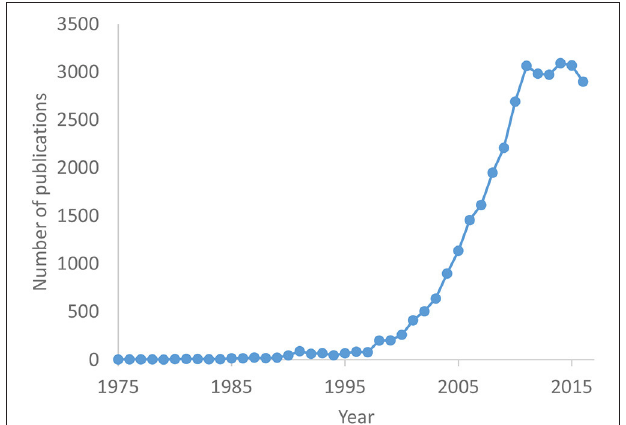
FIGURE 1 | Number of publications registered in Scopus by year, including the words “biological invasions” or “non-indigenous species” or “alien species” or “invasive species.”